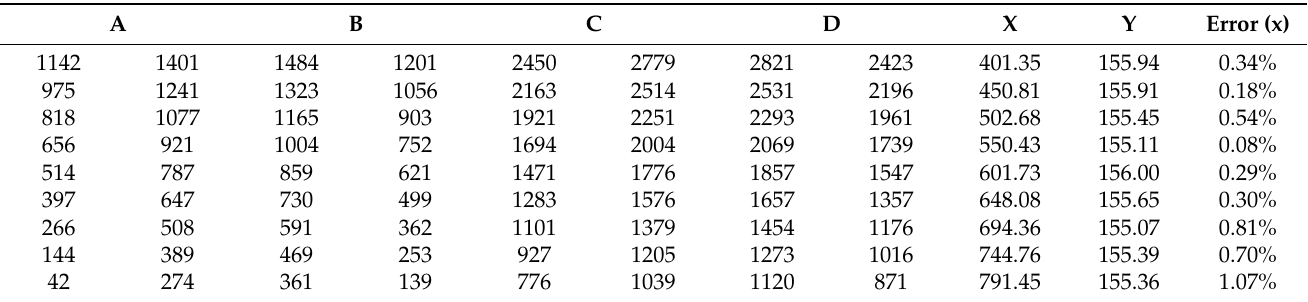
Figure 10. ( a ) The model truck photographed by the camera in Test 1. ( b ) Trajectory of the model truck in Test 1. Table 1. Pixel coordinates of four selected points and identification results in Test 1.